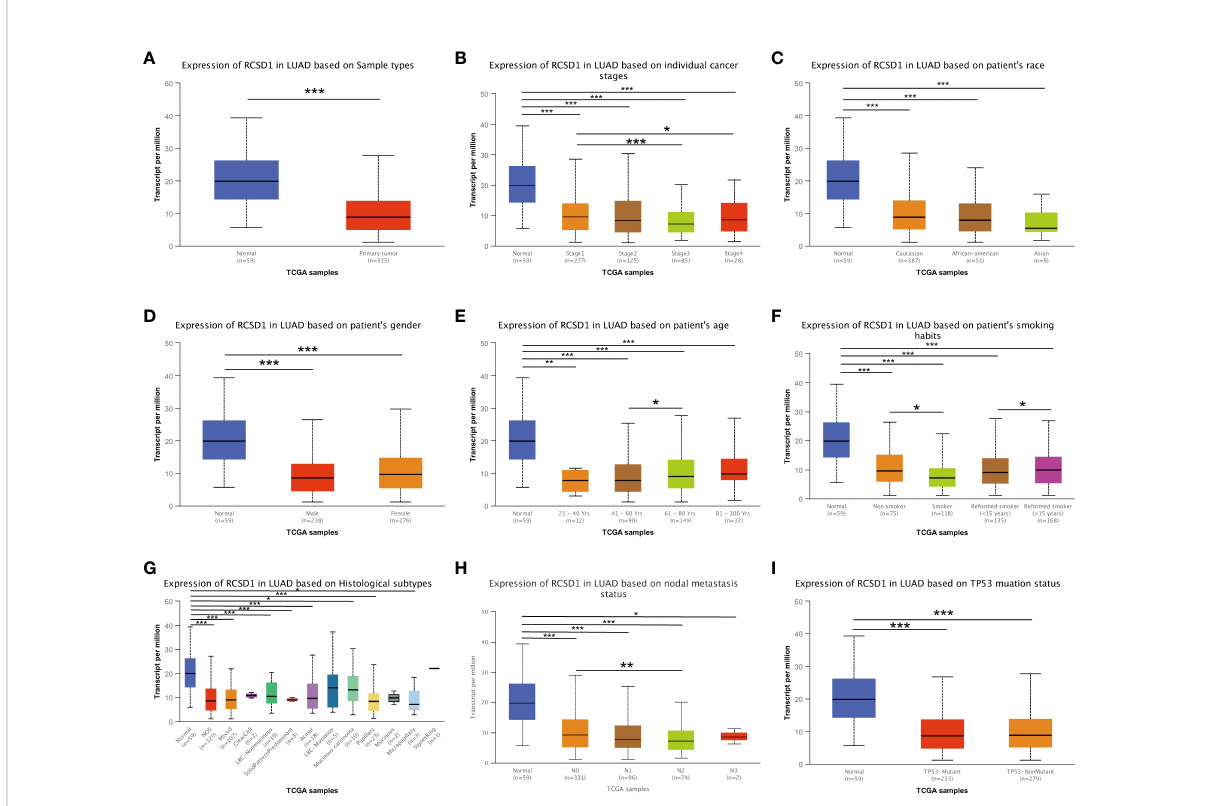
FIGURE 7 RCSD1 differential expression in LUAD with different clinical subgroups. On (A) sample types, (B) individual cancer stages, (C) patient ’ s race, (D) patient ’ s gender, (E) patient ’ s age, (F) patient ’ s smoking habits, (G) histological subtypes, (H) nodal metastasis status and (I) TP53 mutation status. *, P < 0.05; **, P < 0.01; ***, P <